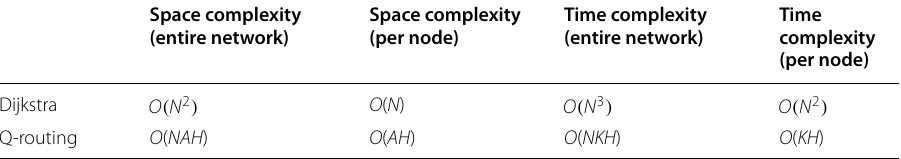
Space complexity (entire network)